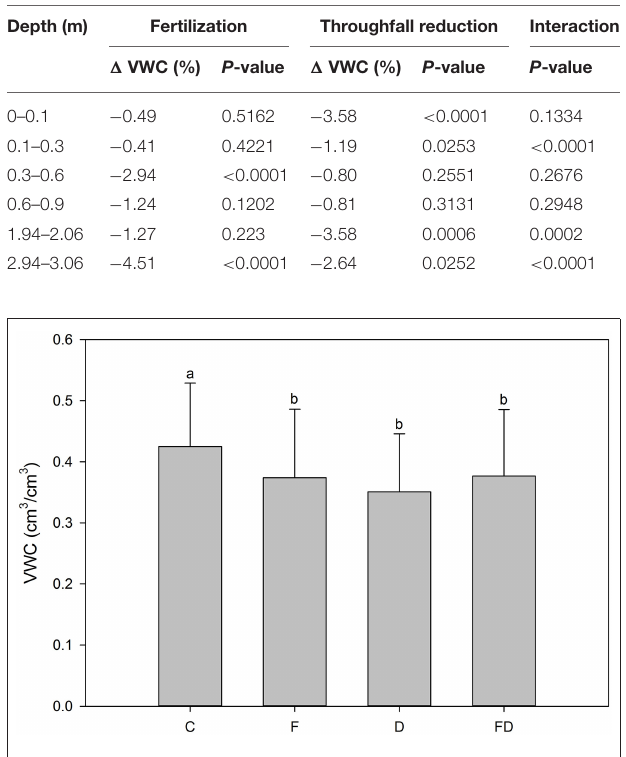
FIGURE 6 | Treatment [control (C), fertilization (F), throughfall reduction (D), and FD] effects on volumetric water content (VWC) of 1.94–2.06m soils. Bars represent the means of VWC (over the period of March 2013 to July 2015) and error bars represent ± 1 SE ( n = 108). Letters indicating differences for Tukey’s significance test at the level of α = 0.05 were used to separate treatment effect on